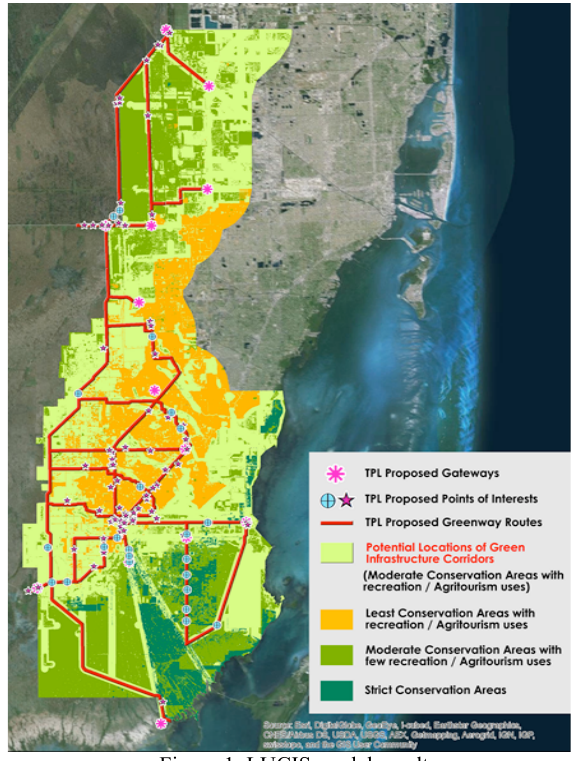
Figure 1. LUCIS model results